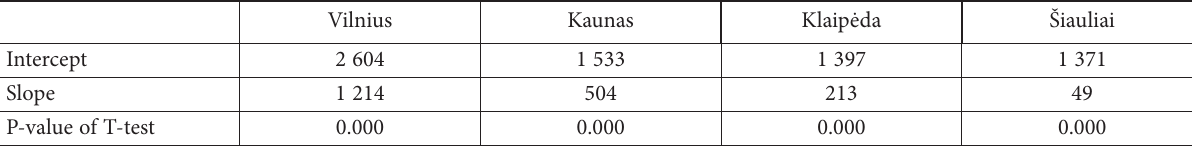
Table 3. Coefficients of a simple linear regression between the number of newcomers and housing affordability index Vilnius Kaunas Klaipėda